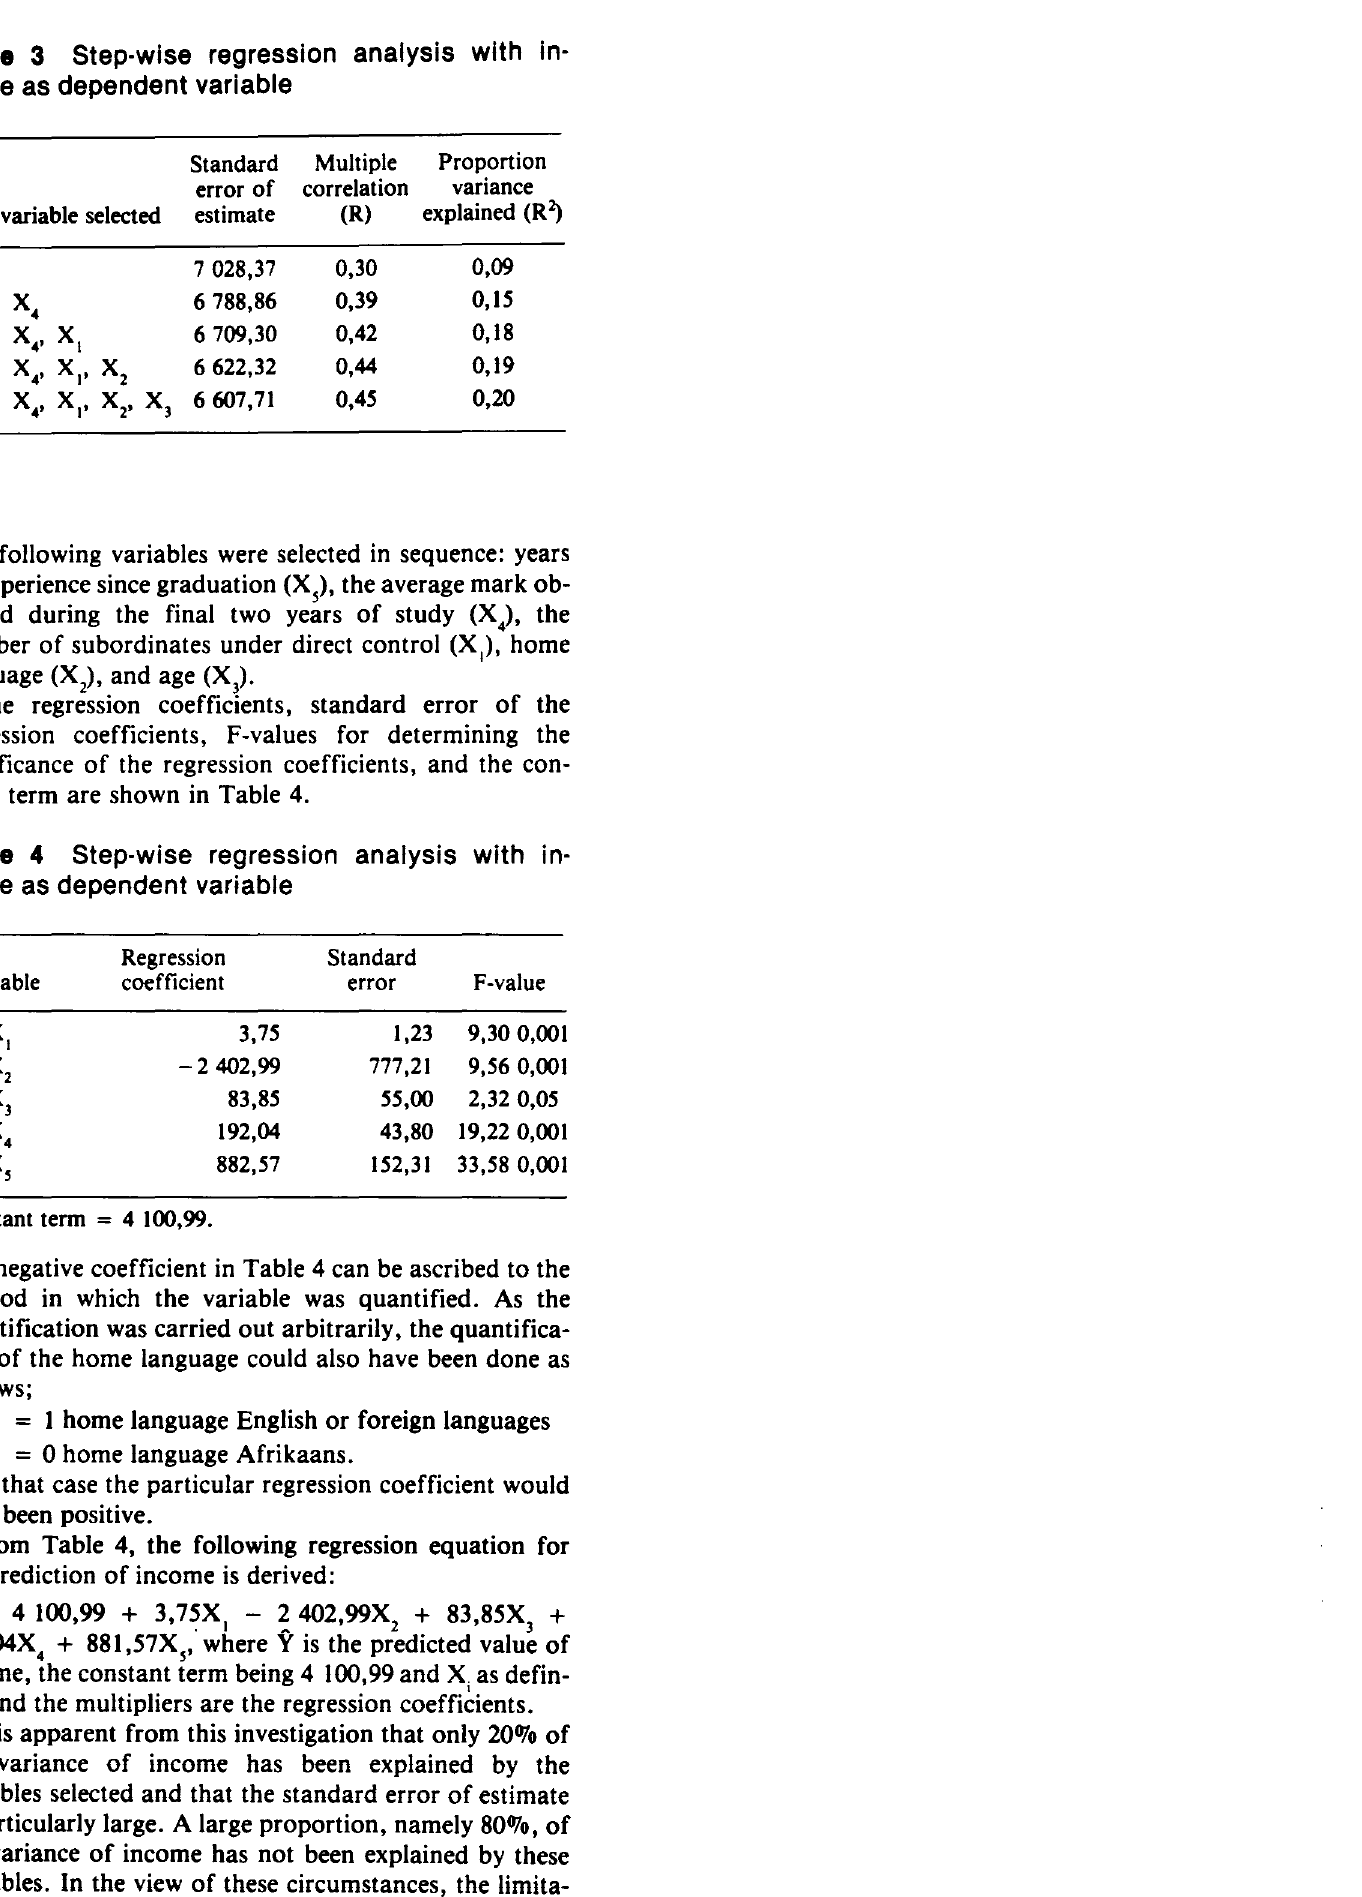
Step-wise regression analysis with in come as dependent variable